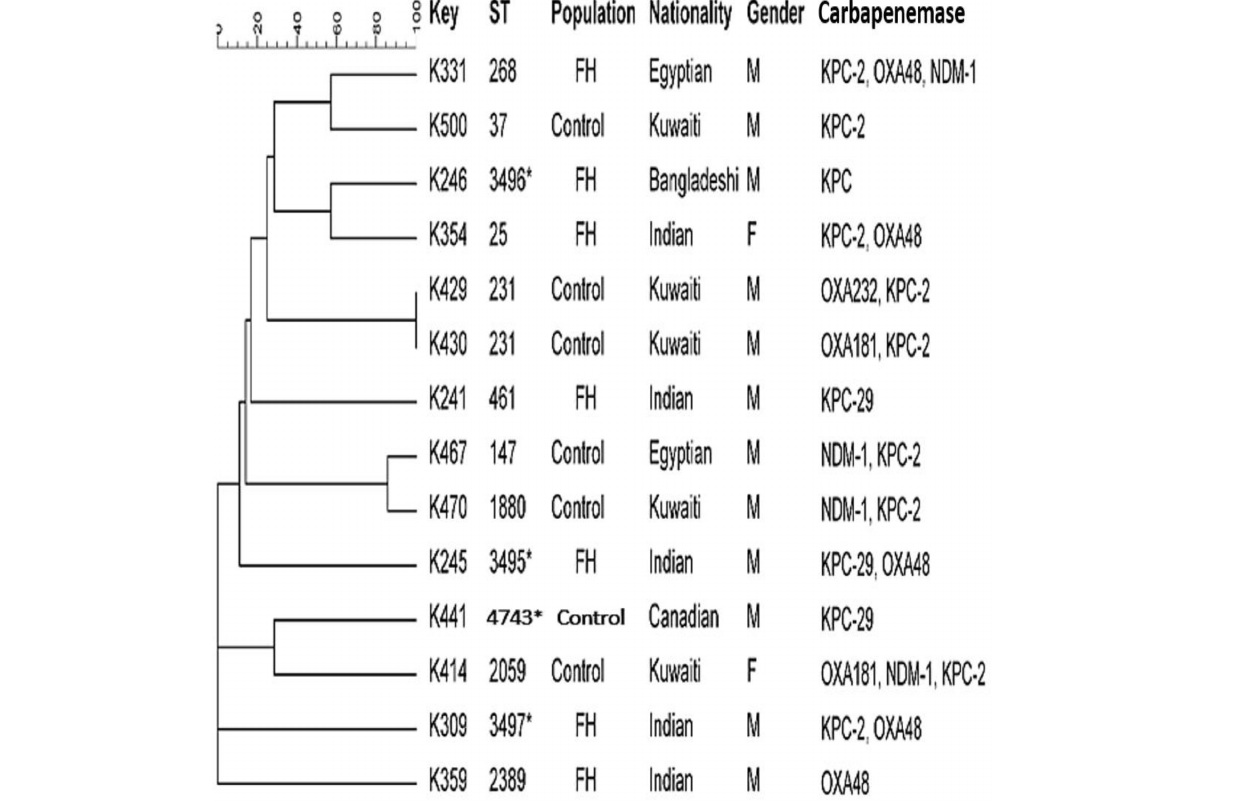
FIGURE 3 | Dendrogram of Klebsiella pneumoniae obtained from food handlers and infected control patients showing clonal relatedness demonstrated by cluster analysis based on their MLST. The characteristics of the major clones generated using minimum spanning trees by BioNumerics software v6.1 (Applied Maths, Kortrijk, Belgium) are also highlighted. Similarity in the isolates is presented in percentages using the scale bar in the upper left corner. In the Key column, K represents K. pneumoniae , STs = sequence type; population = food handler (FH) and infected control patients; nationality; gender F = female, male = male; and carbapenemases. MLST, multilocus sequence